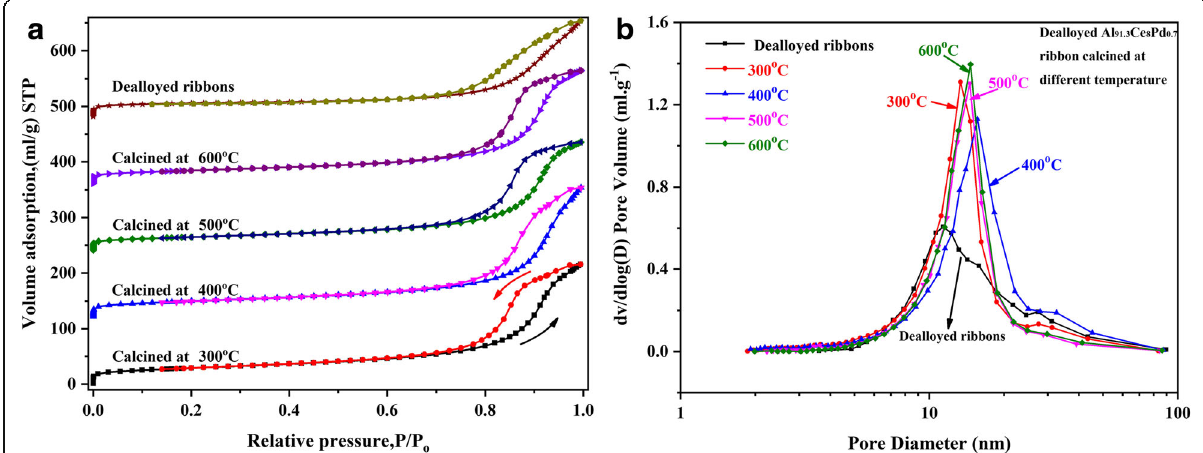
Fig. 5 Nitrogen adsorption-desorption isotherm curves ( a ) and pore size distribution curves ( b ) of dealloyed Al 91.3 Ce 8 Pd 0.7 ribbons calcined at different temperatures